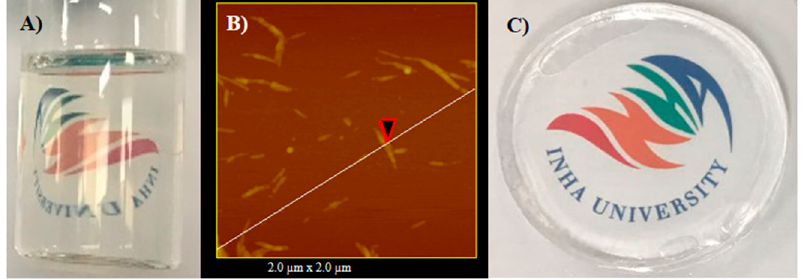
Figure 2. ( A ) Photograph of the prepared cellulose nanocrystal (CNC) suspension, ( B ) atomic force